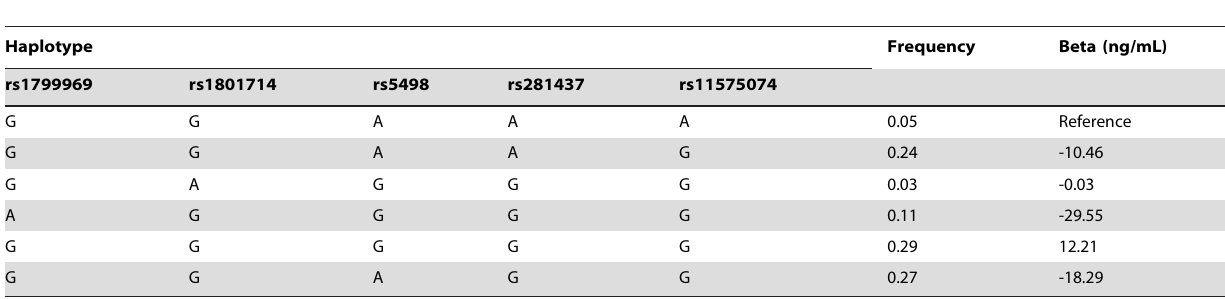
Table 2. Haplotype Analysis of rs1799969, rs1801714, rs5498, rs281437, and rs11575074 (19p13.2; ICAM1 locus).